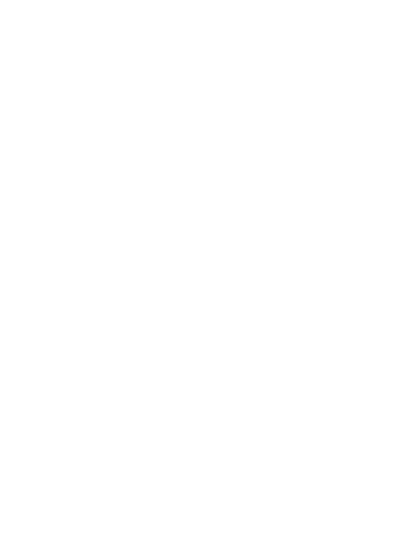
Table 2. The hyperparameters of four